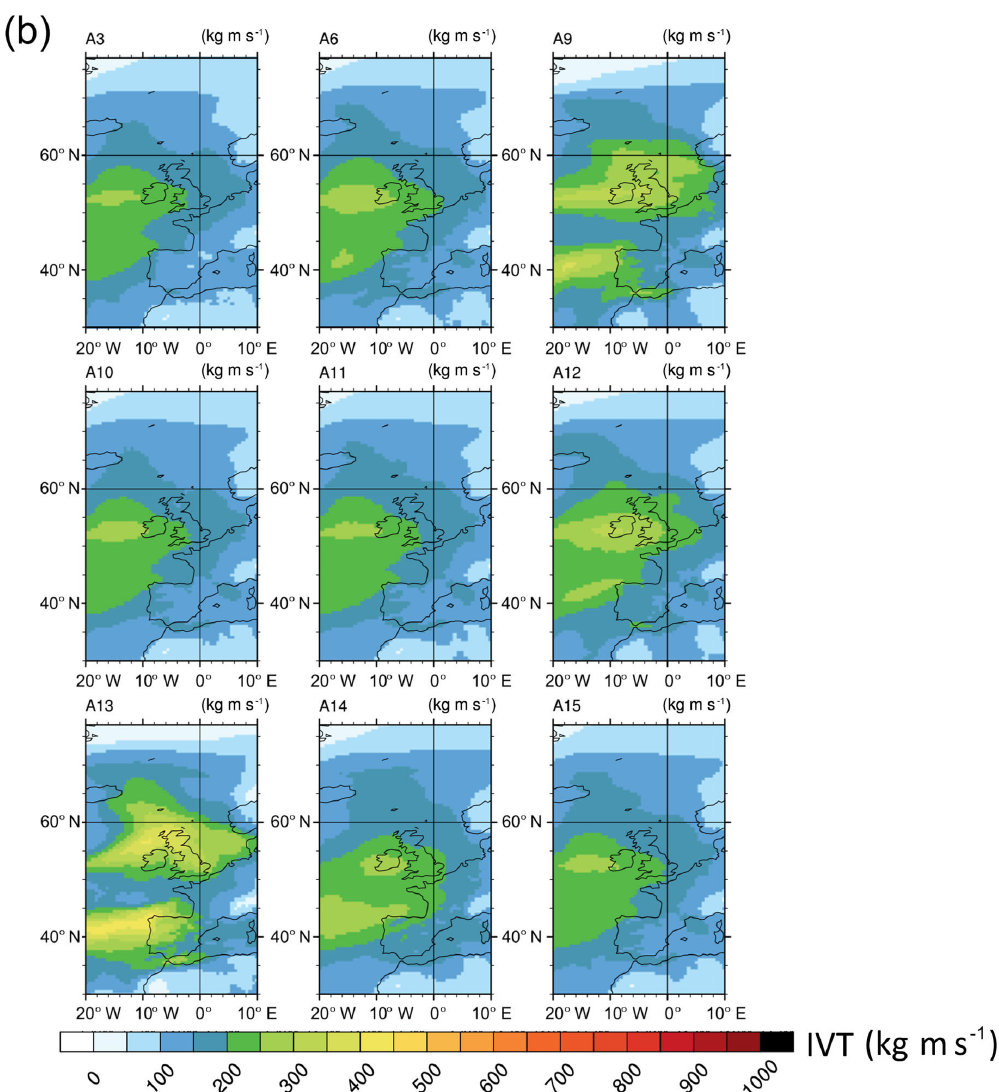
Figure 6. (a) Composite MERRA-2 IVT (kgm − 1 s − 1 ) but for landfalling ARs only along the North American west coast. Time instances where an AR was detected along the coastline were composited for the entire region. Algorithm masks are not necessary. (b) Same as panel (a) except for European coastlines. Note that the number of algorithms in this figure differs from panel (a) due to the regional constraint of the respective